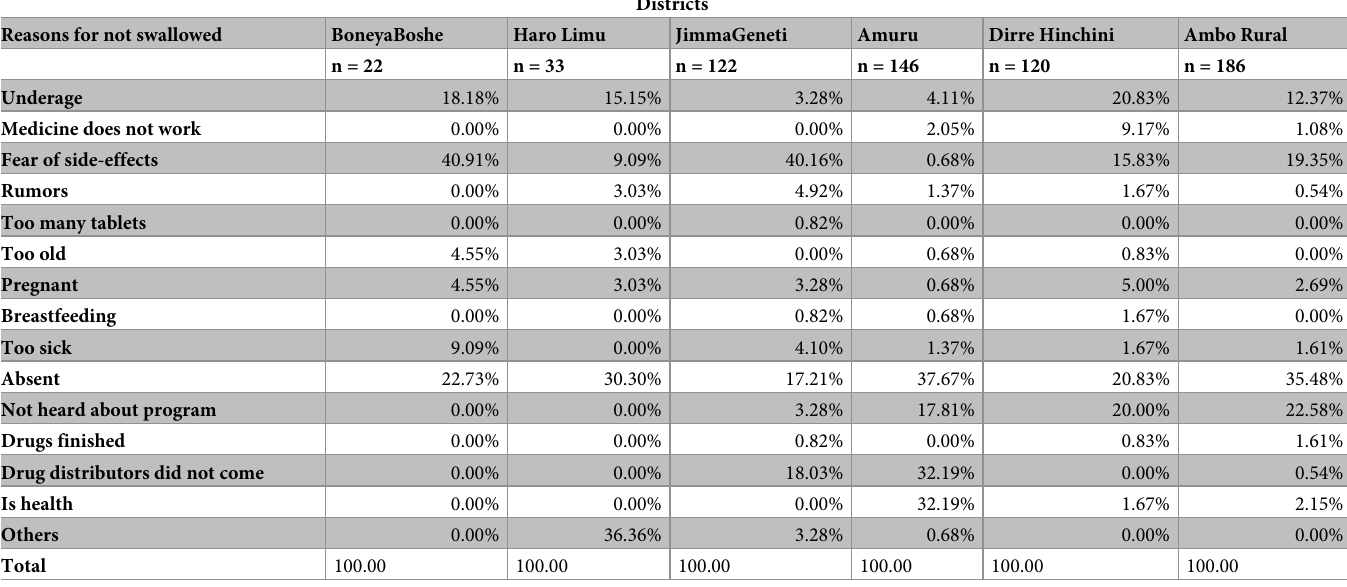
Table 9. Reasons for not swallowing MDA drugs in six districts of East Wollega, West Shewa and Horo Guduru Zone Wollega, Oromia 2017.